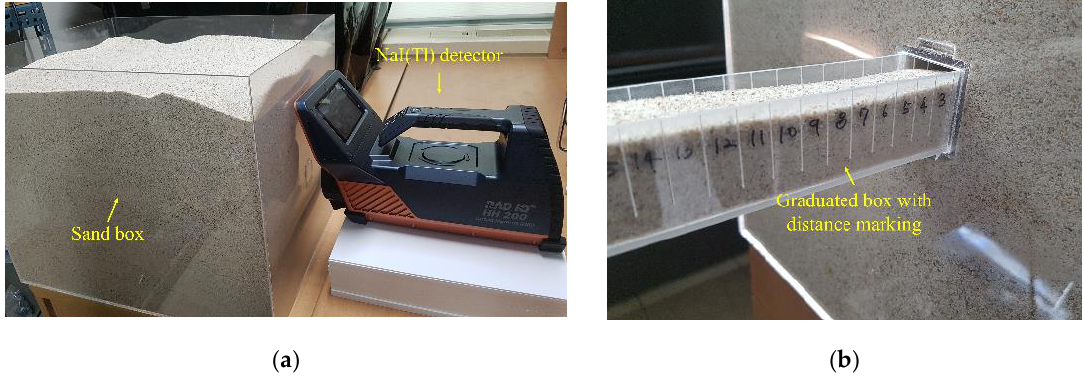
Figure 1. ( a ) An acrylic box filled with sand and an NaI (Tl) detector for gamma spectroscopy; and ( b ) a graduated box marked with the buried distance of the source measured from the front surface of the sandbox.